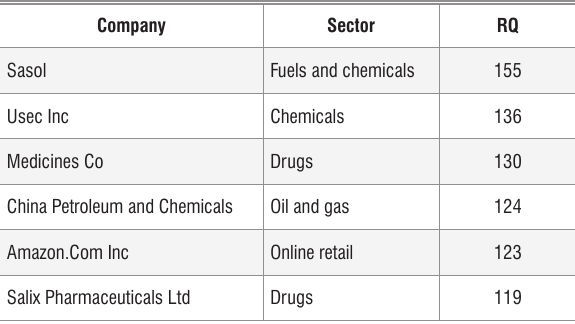
A comparison of Research Quotient (RQ) for Sasol and other leading international companies